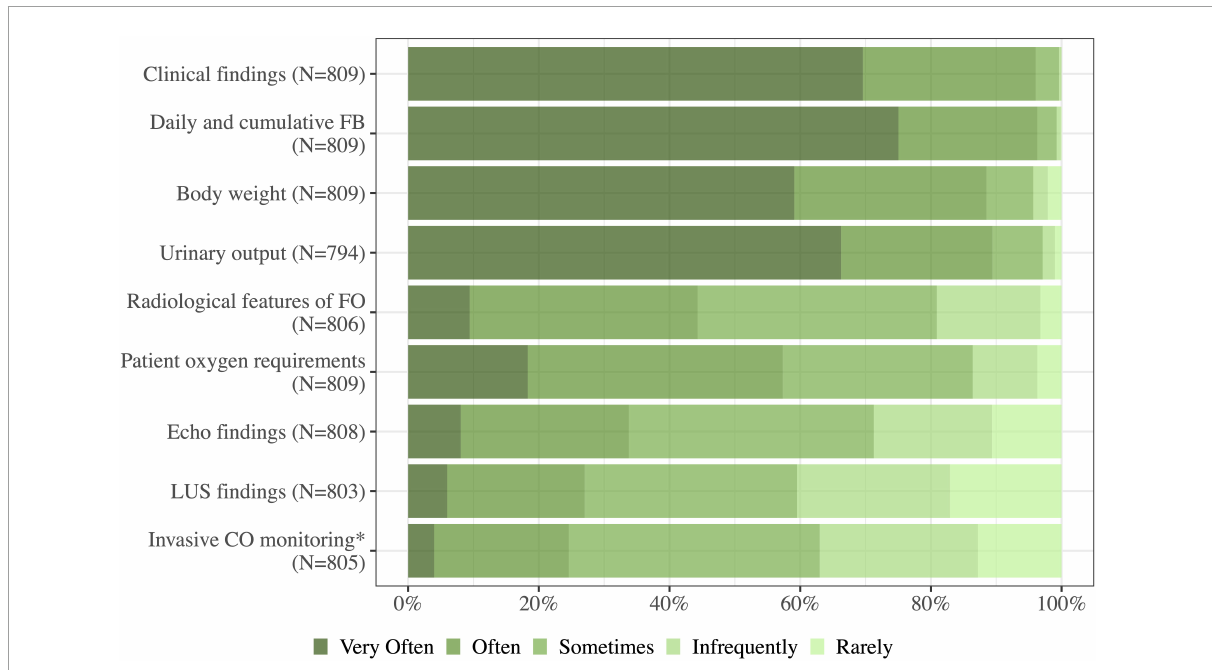
FIGURE3 As a part of my routine clinical practice, I use the following when assessing the fluid status of a critically ill patient: FB, fluid balance; FO, fluid overload; LUS, lung ultrasound; CO, cardiac output; N, number of respondents to the question. ∗ Results from invasive cardiac monitoring and measures of fluid responsiveness from these devices.